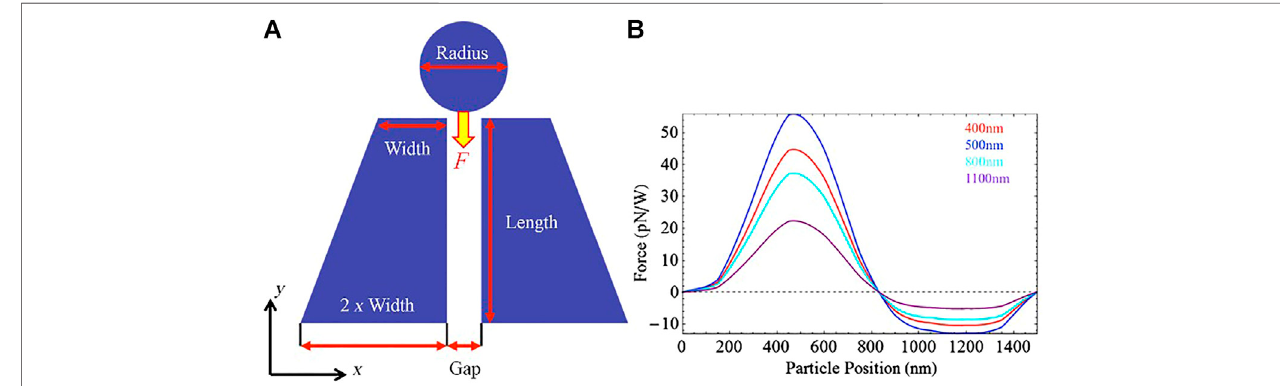
FIGURE 10 | (A) A cut in the xy plane of the trapezoidal structure, showing the direction of the ejection force; (B) the graph of the force as the y coordinate of the nanoparticle changes. Adapted from Rovey et al. (2015).